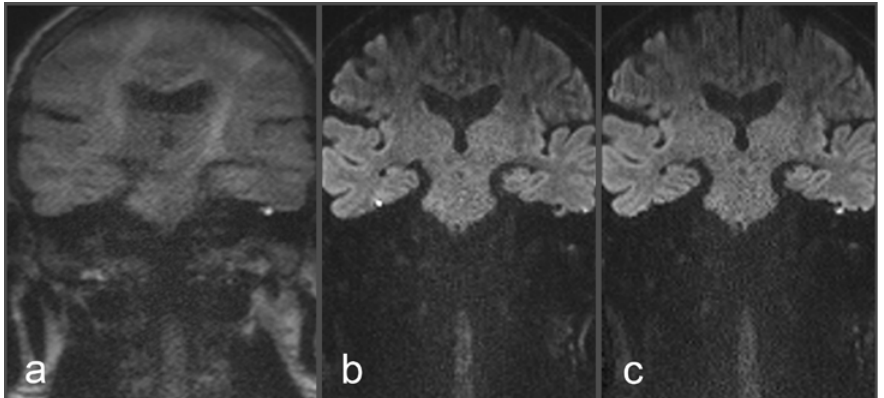
Figure 2. Images of a 48-year-old patient with a suspected cholesteatoma on the left side. ( a ) tseDWI. ( b ) uncorrected rsDWI. ( c ) topup-corrected rsDWI (each sample image in coronal slice orientation). Both tseDWI and topup-corrected rsDWI show a small hyperintense lesion in the upper middle ear on the left side, which could be confirmed as a cholesteatoma after surgery and histopathological examination. In contrast, uncorrected rsDWI was not able to delineate the cholesteatoma on the left side with comparable hyperintense signal intensity and shows a strong geometrical distortion of the lesion. Additionally, uncorrected rsDWI demonstrates two additional lesions: punctual on the left lateral side and brightly appearing on the right side; both were valued as artifacts due to their absence in tseDWI and topup-corrected rsDWI, respectively.